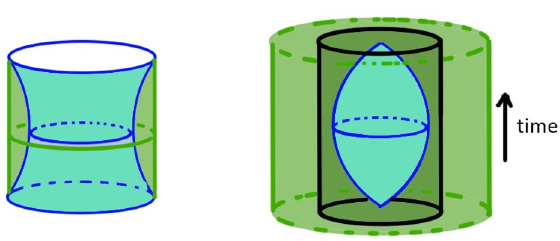
Figure 2 . The Black Hole Microstate Cosmology (BHMC) construction. Left: a holographic CFT theory on a Euclidean cylinder with boundary degrees of freedom at the two ends is dual to a Euclidean spacetime with an end-of-the-world (ETW) brane having the geometry of a Euclidean wormhole. Right: in the associated Lorentzian geometry, the ETW brane lives behind a black hole horizon and has the geometry of a closed-universe big-bang/big-crunch cosmology. With many boundary degrees of freedom in the original picture, gravity can be localized to this ETW